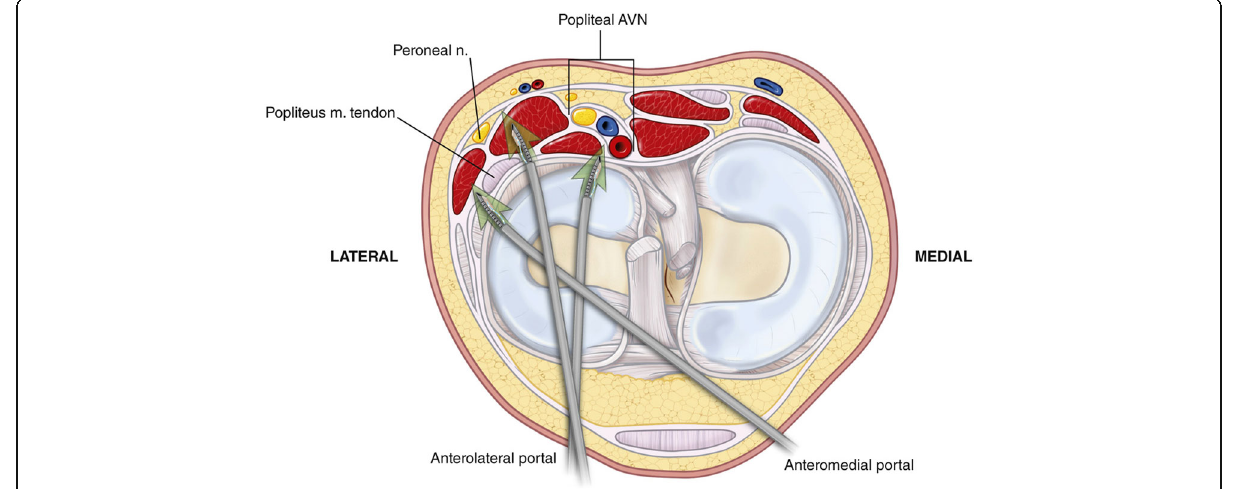
Fig. 1 Axial schematic of the all-inside meniscal repair devices and the neurovascular structures of a left